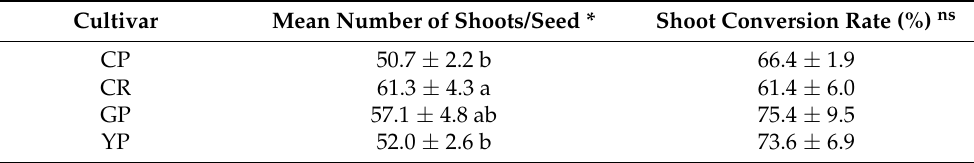
Values represent the mean ± standard errors of three independent experiments. ns , *: non-significant or significant at p ≤ 0.05, respectively, as determined by ANOVA. Different letters within each column represent significant differences at p ≤ 0.05, as determined by Duncan’s multiple comparison test. CP, Chunpoong; CR, Cheonryang; GP, Gumpoong; YP, Yunpoong.